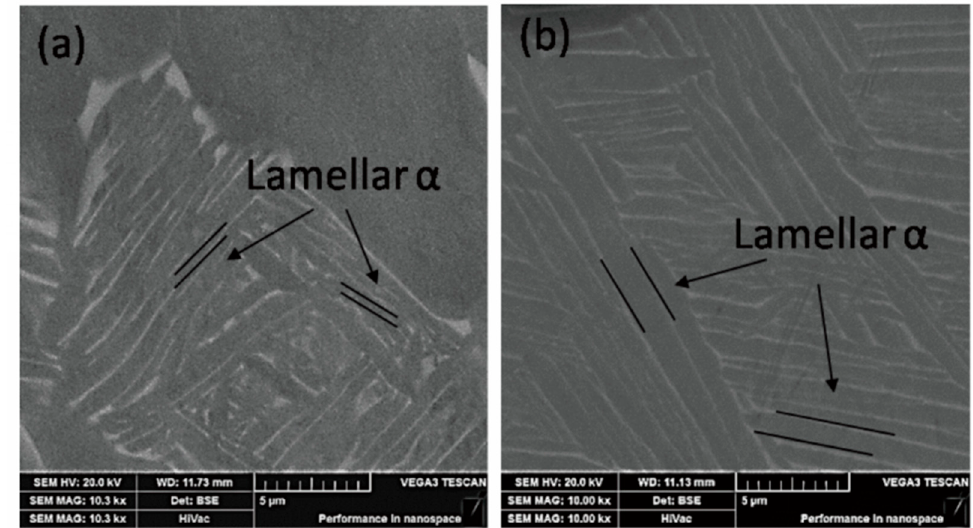
Figure 6. BSE image of microstructures obtained by different solid solution treatment: ( a ) 940 °C ×1 h, AC; and ( b ) 980 °C × 1 h, AC.